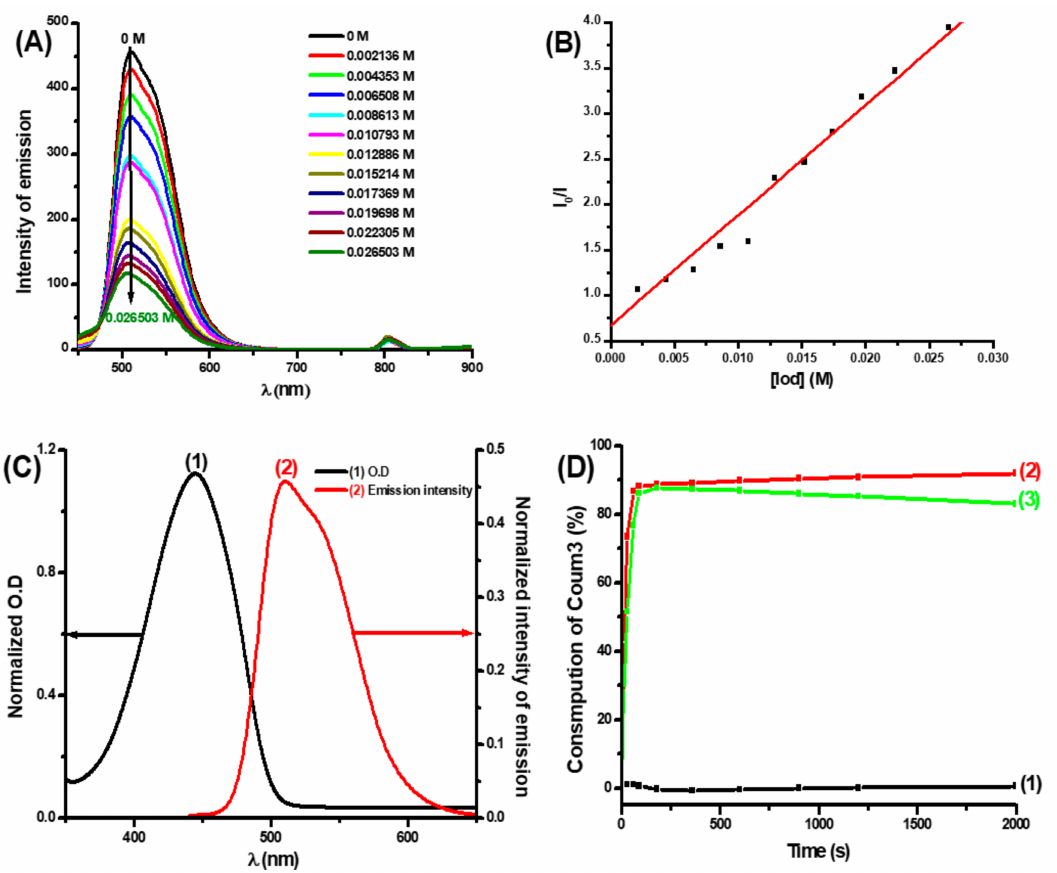
Figure 6. ( A ) Quenching of Coum3 by Iod, ( B ) Determination of the Stern–Volmer coe ffi cient, ( C ) Determination of ES1, ( D ) Consumption of Coum3: (1) Without Iod, (2) With Iod (10 − 2 M), and (3) With Iod / EDB vs. irradiation time upon exposure to the LED @ 375 nm in